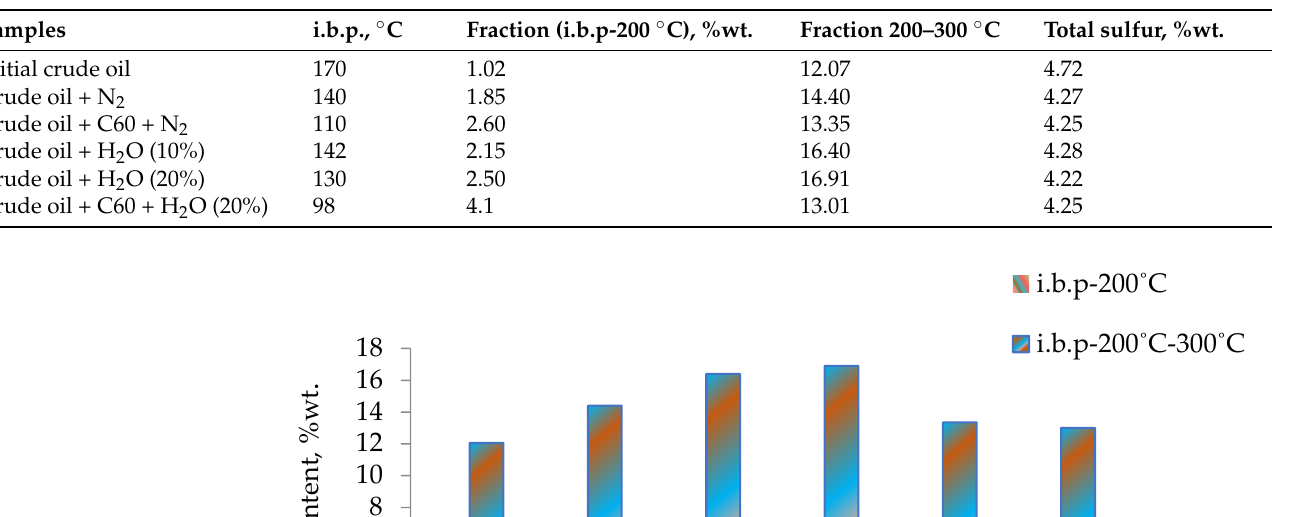
Table 1. Atmospheric distillation yields and total sulfur contents.